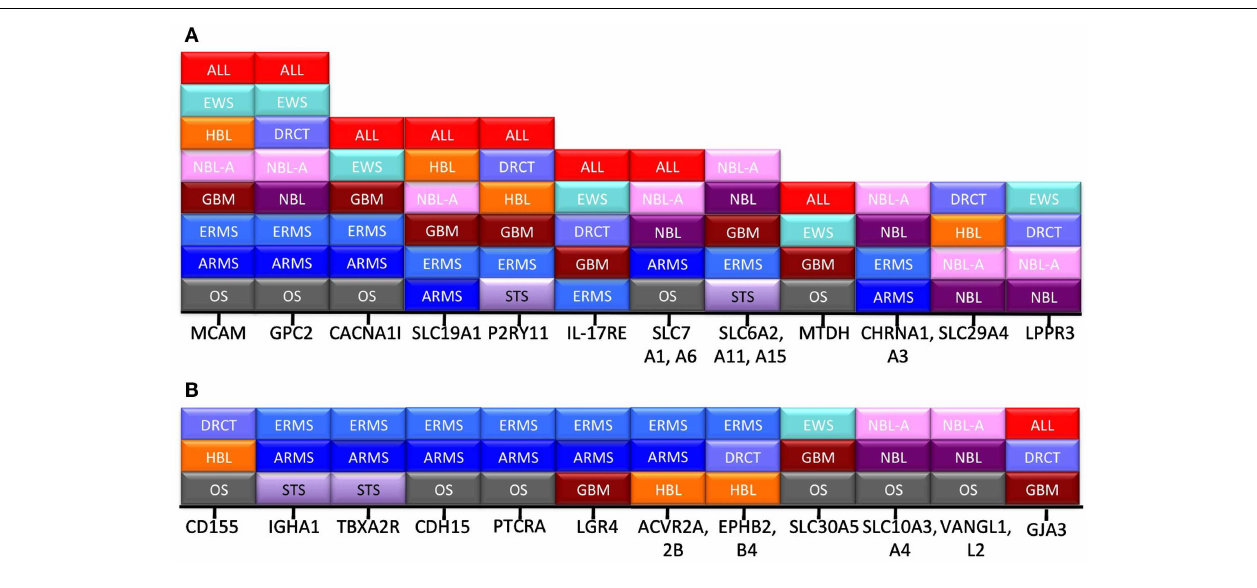
three (B) , cancer types are listed.The x -axis lists the individual gene, and the stacked boxes represent presence of that transcript in theTop 25 for that disease